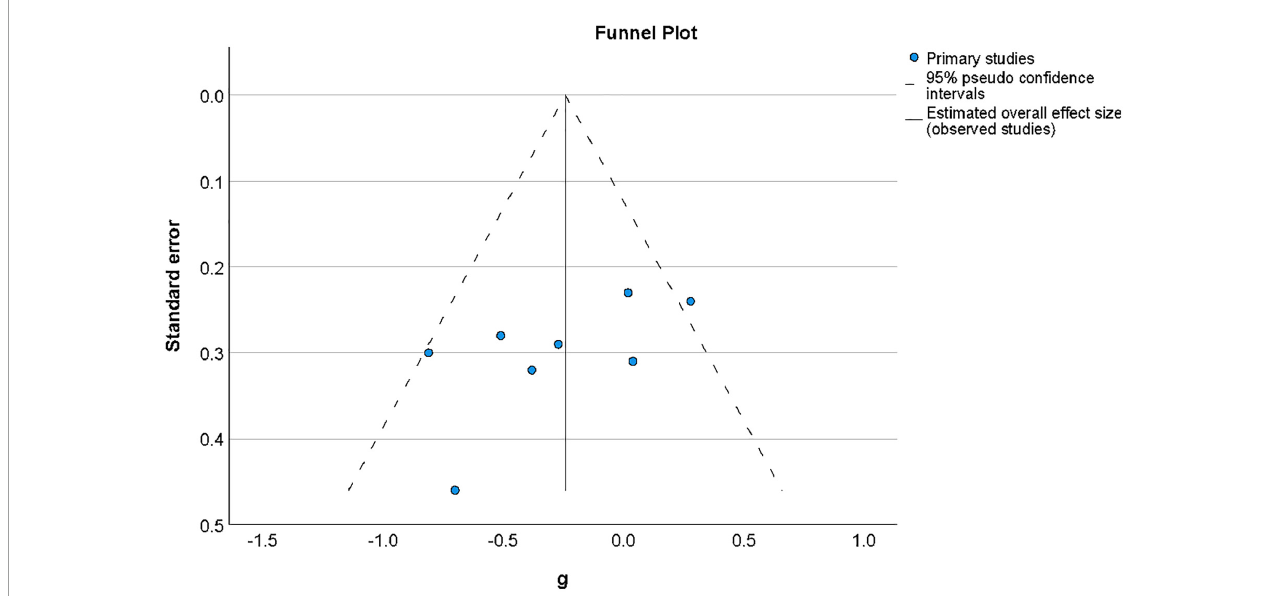
FIGURE6 Funnel plot of effect sizes by standard error for studies of metacognition in the presence of non-psychotic symptoms of mental disorder. The vertical line indicates the value of the summary effect size. The area of the graph within the triangle represents the values which samples have 95% probability of showing if variance is